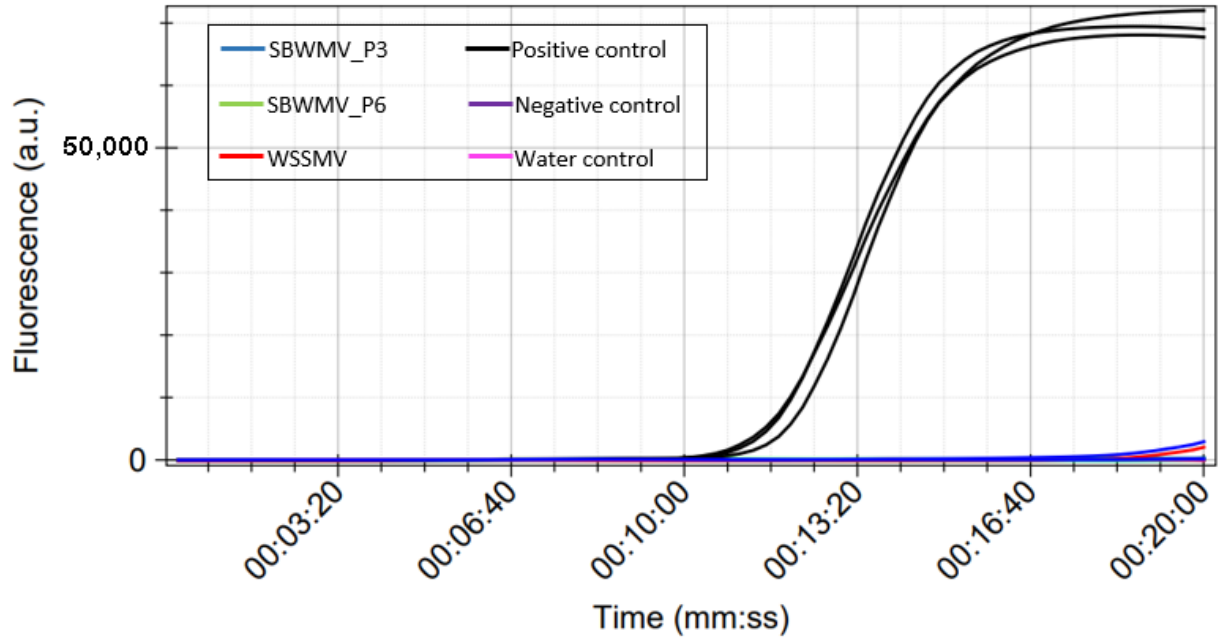
Figure 4. LAMP test performed on cDNA from samples infected with SBWMV and WSSMV diluted 10 − 4 . Experiment performed in the bCUBE instrument. Table 6. Comparison of RT-LAMP assay on crude extracts prepared from mechanically inoculated plants at different dilutions in TET and Tris buffers. Experiment performed in the bCUBE instrument. Rt: reaction time; SD: standard deviation; nd: not